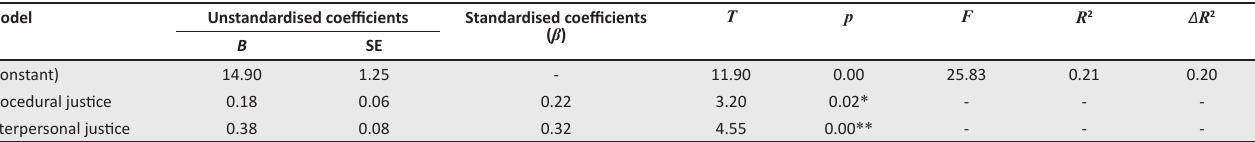
TABLE 4: Multiple regression analysis with intrinsic job satisfaction being the dependent variable and procedural justice and interpersonal justice the independent variables.